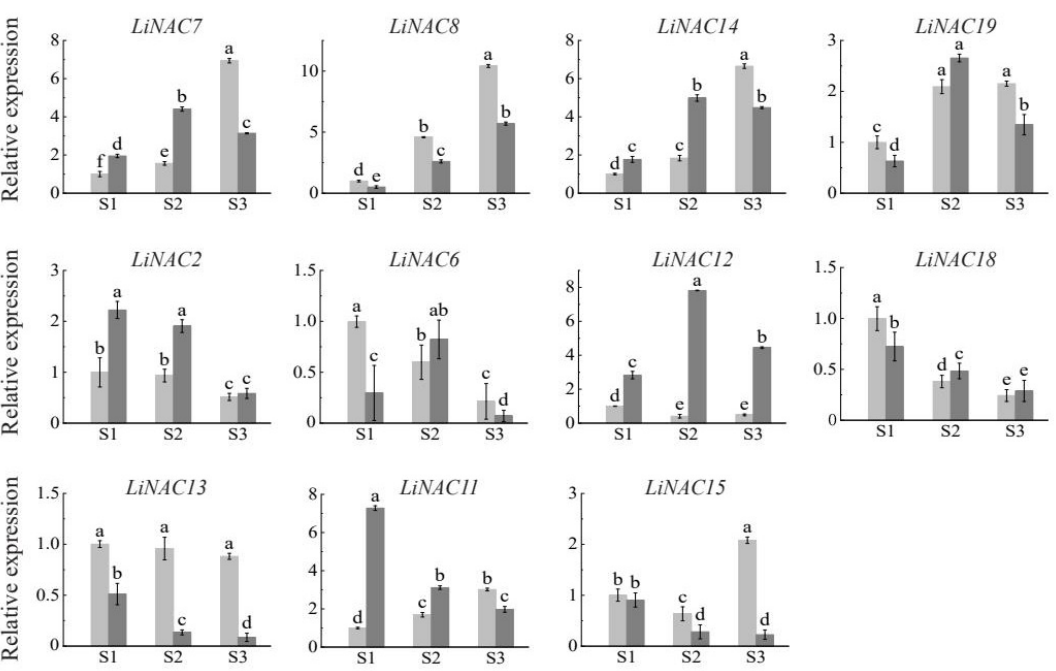
Figure 7. The qRT-PCR analysis of 21 LiNAC genes in Upright and Weeping L. indica at different growth stages. S1, S2, and S3 indicate the early growth stage, the growth stage, and the end of the growth stage; significant differences are identified by SPSS with Duncan’s test ( p < 0.05) and are represented by different letters above the error bars.